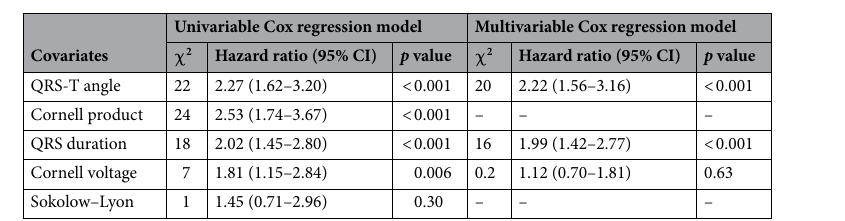
Table 2. Uni- and multivariable Cox regression analysis for the QRS-T angle, QRS duration, Cornell voltage product, Cornell voltage, and Sokolow–Lyon index in the Clinical-Consecutive cohort for predicting the composite outcome of hospitalization for heart failure and all-cause mortality. Covariates were analyzed as binary variables with cut-offs for left ventricular hypertrophy. See text for details on cut-offs. Cornell product was not included in multivariable analysis due to being mathematically related to QRS duration and Cornell